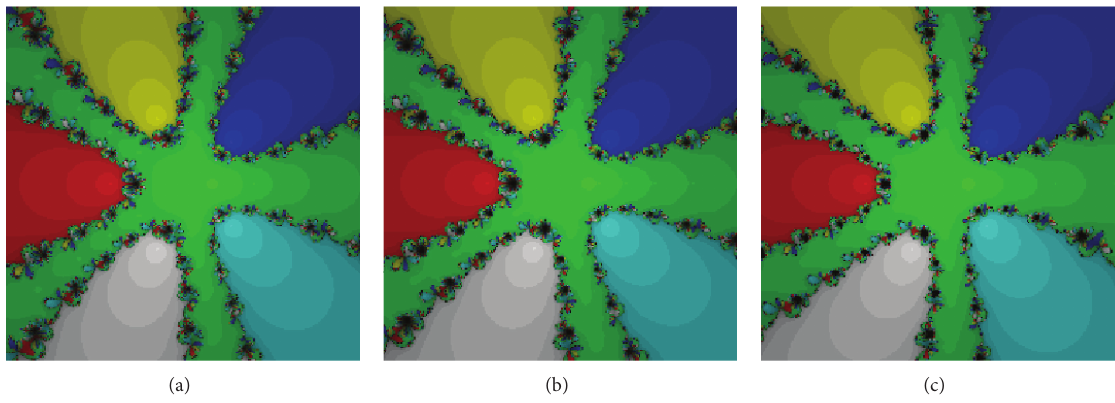
Figure 3: The basins of attraction for CM 1 4 (a), KM 4 (b), and MKM 4 (c) in problem